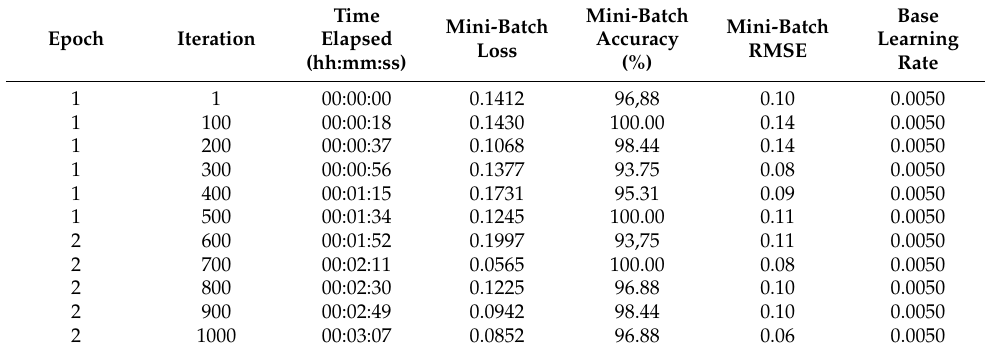
Table 3. Re-training Fast R-CNN using updated